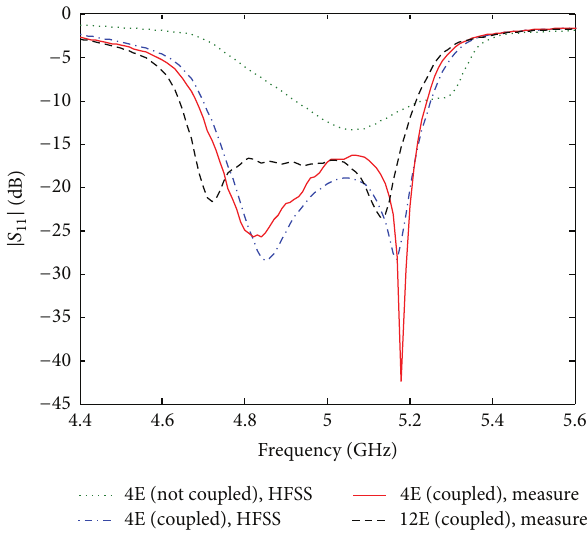
Figure 3: Reflection coefficients for the 4-element Yagi array of quarter-wave patch antennas without microstrip lines coupling, the 4-element Yagi array with microstrip lines coupling (Figure 2), and the 12-element Yagi array with microsrip lines coupling (Figure